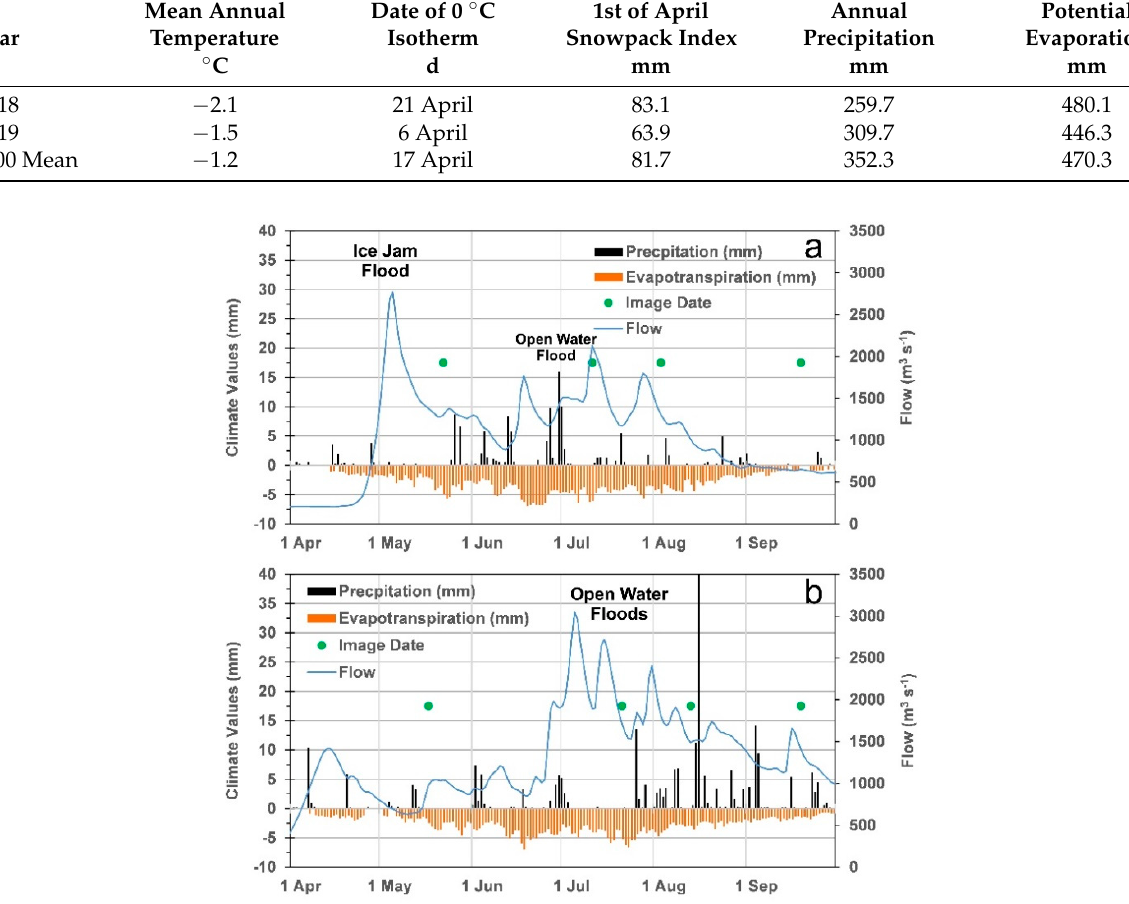
Figure 5. Hydrometeorological data for the 2018 ( a ) and 2019 ( b ) study periods. Flow is on the lower Athabasca River at Embarras Airport just before entering the delta, potential evapotranspiration estimated via the Hamon (1961) model using climate data from Fort Chipewyan area.